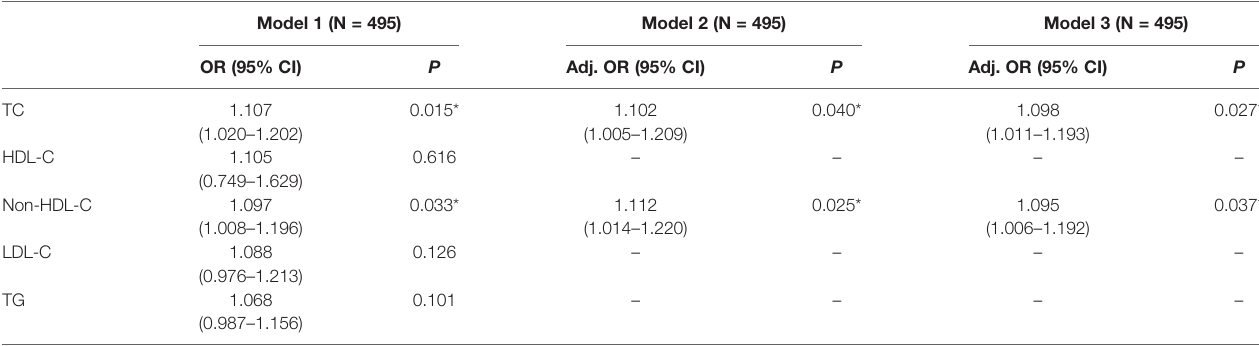
TABLE 3 | Logistic regression analyses for lipid pro fi les and IgG4 dominant deposit.